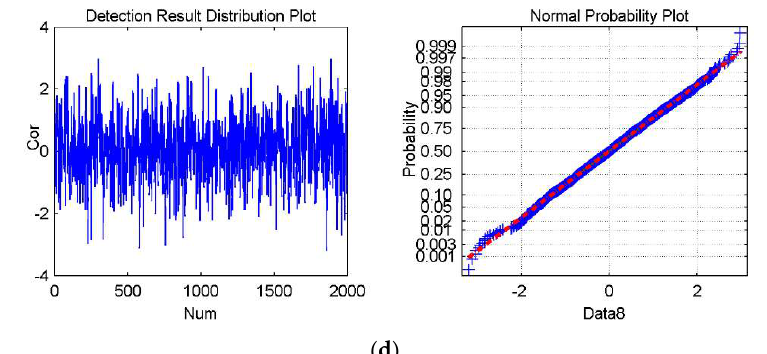
Figure 9. The experimental results for Watermark1 and Watermark2, which are the cover data. ( a – d ) shows the detection result distribution plot and the normal probability plot of Data5, Data6, Data7, and Data8, respectively. The mean is −0.0134 and the standard deviation is 0.9969 in ( a ); the mean is 0.0058 and the standard deviation is 1.0296 in ( b ); The mean is −0.0284 and the standard deviation is 1.0253 in ( c ); The mean is −0.0022 and the standard deviation is 1.0144 in ( d ).